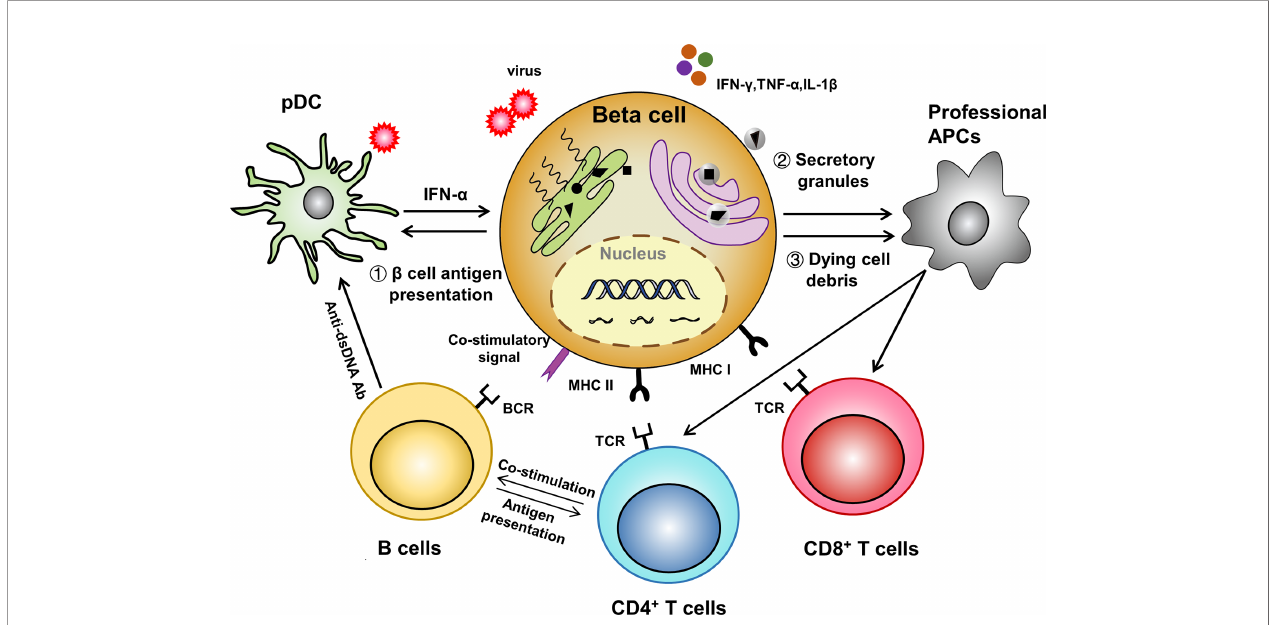
FIGURE 1 | A b cell centered view of antigen-presentation. (1) Stressed APC-like b cells directly present antigens to activate adaptive immune cells; (2) Dysfunctional b cells secret autoantigen containing granules which are subsequently up-taken and processed by professional APCs; (3) Dying b cells themselves and the released pro-in fl ammatory molecules further amplify the antigen presenting